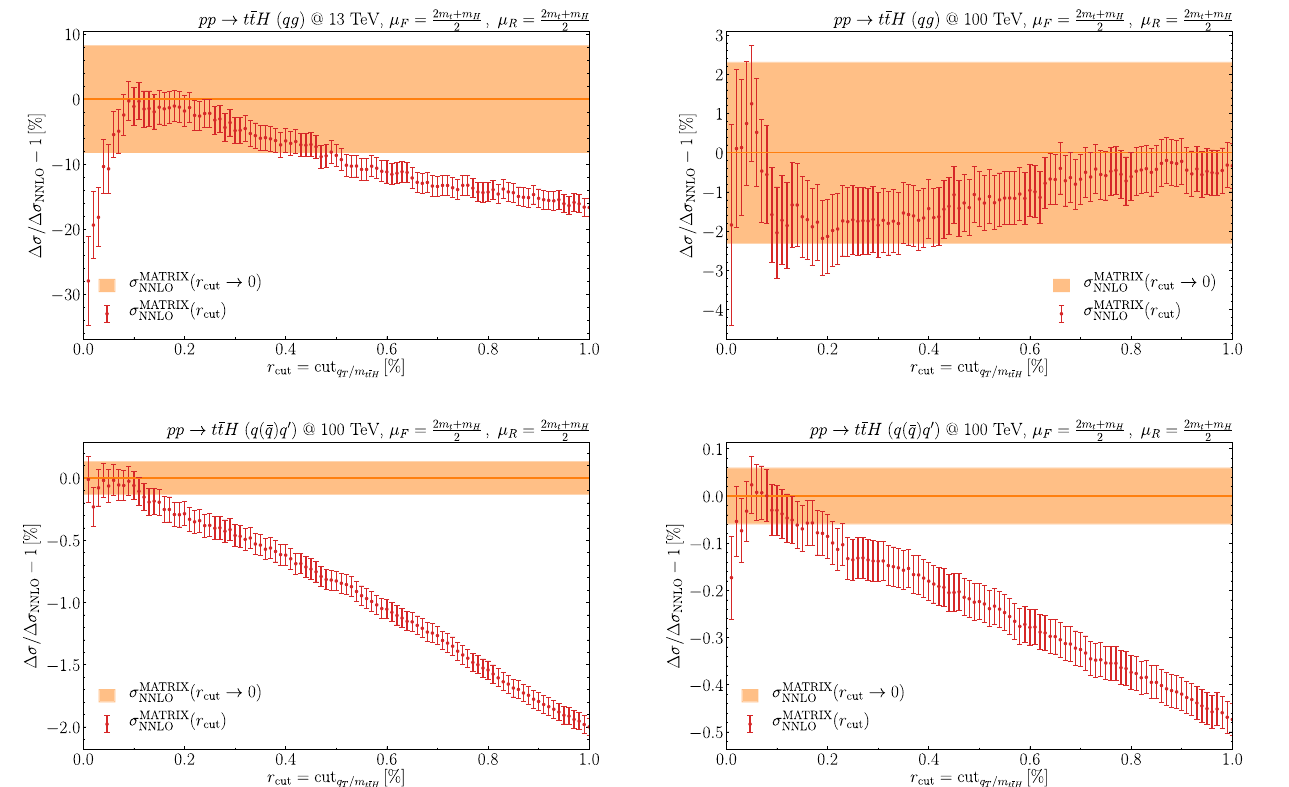
√ s = 13 TeV (left) and